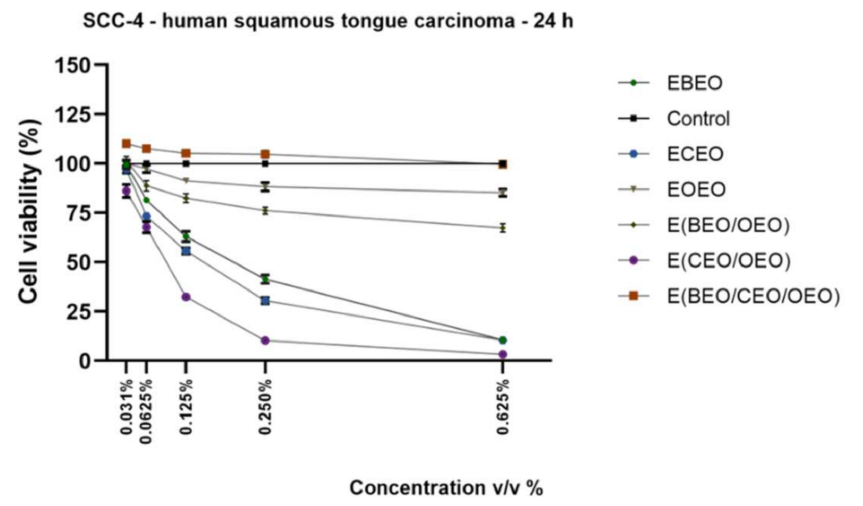
Figure 7. In vitro viability assessment of EOs emulsions (EBEO, ECEO, and EOEO) and their mixtures E(BEO/OEO), E(CEO/OEO), and E(BEO/CEO/OEO)) in SCC-4 cells at 24 h post-stimulation by Alamar blue assay. The results are expressed as cell viability percentage (%) normalized to control (unstimulated cells). The data represent the mean values ± SD of three independent